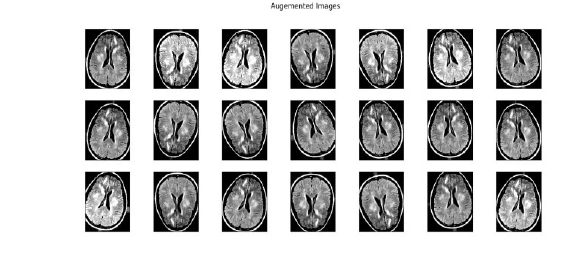
Figure 2. Augmentation Image